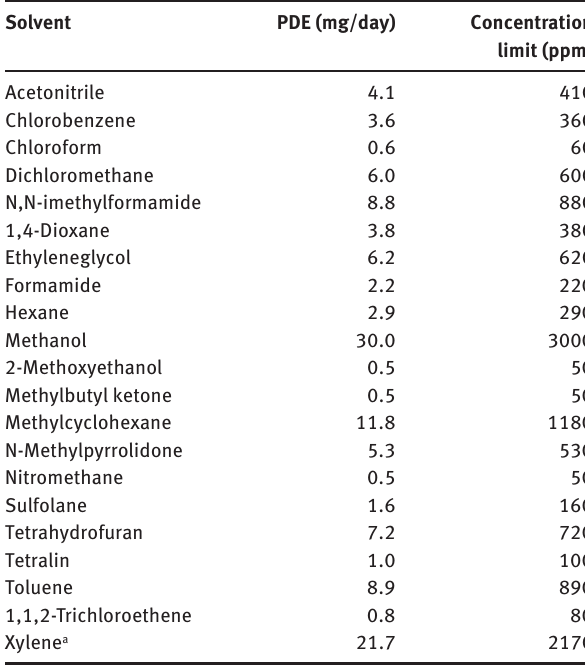
Table 5 Solvents in pharmaceutical products that should be avoided (ICH Q3-C).